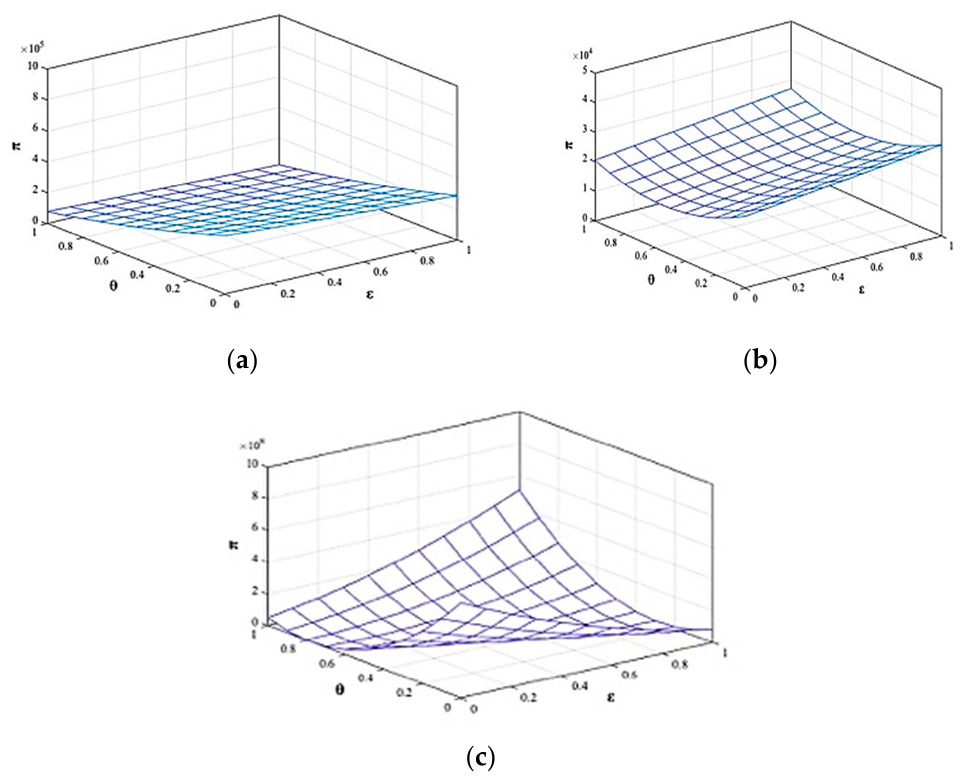
Figure 3. Total profit: ( a ) Manufacturer-led, ( b ) Retailer-led total profit and ( c ) Nash balanced.